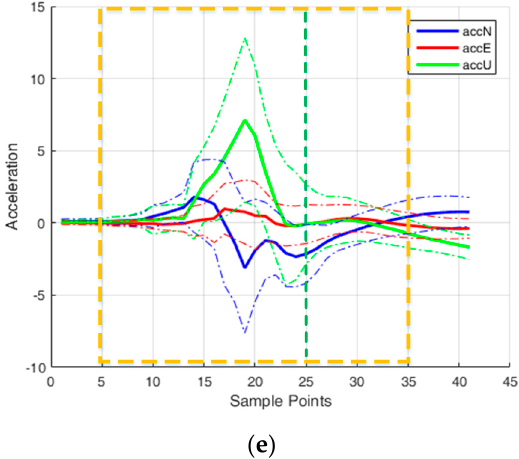
Figure 7. Acceleration signal of different motions and data segmentation: ( a ) Forward; ( b ) Backward; ( c ) Left; ( d ) Right; and ( e ) Jump.